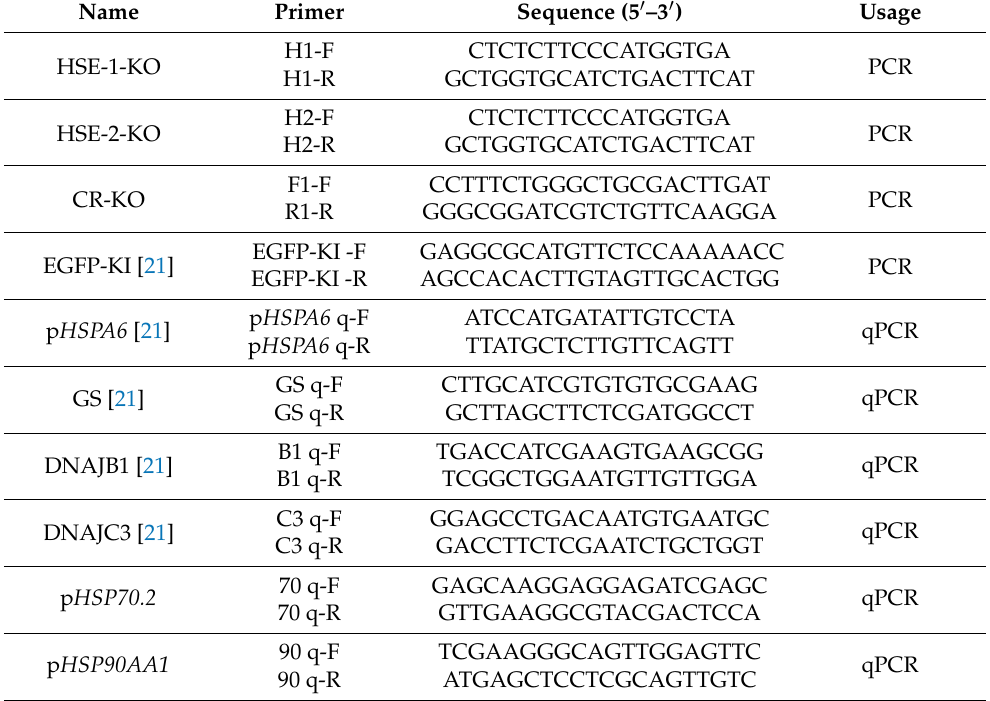
Table 2. Primers used in this